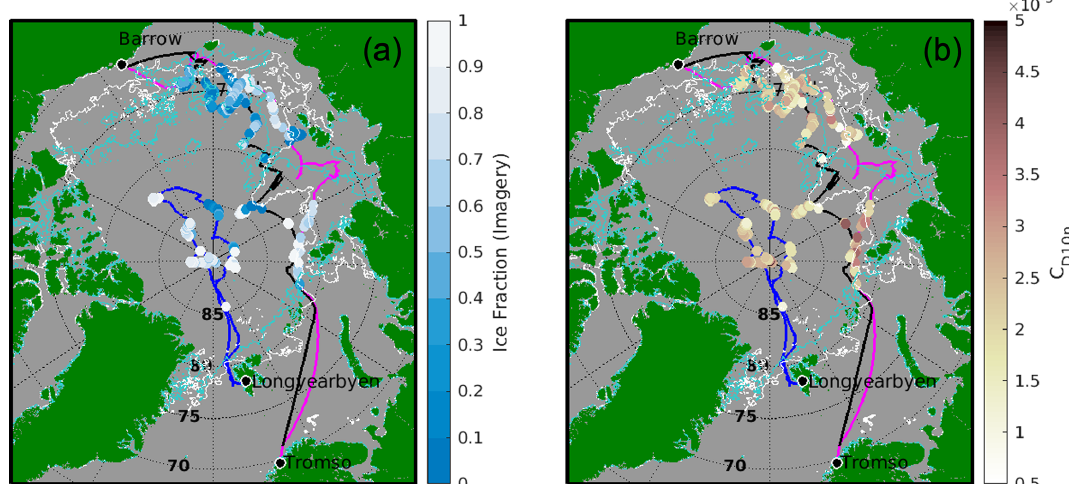
Figure 1. The cruise tracks of ACSE (leg 1, 5 July to 18 August 2014 (magenta) and leg 2, 21 August to 5 October (black)) and AO2016 (8 August to 19 September 2016, (blue)) with (a) sea-ice fraction from in situ imagery and (b) C D10n , for each 30min flux period shown. The sea-ice extent from AMSR2 on 7 August 2014 (white) and 2016 (cyan) – about midway through ACSE and at the start of AO2016 – are shown for reference and to give an indication of the variability between